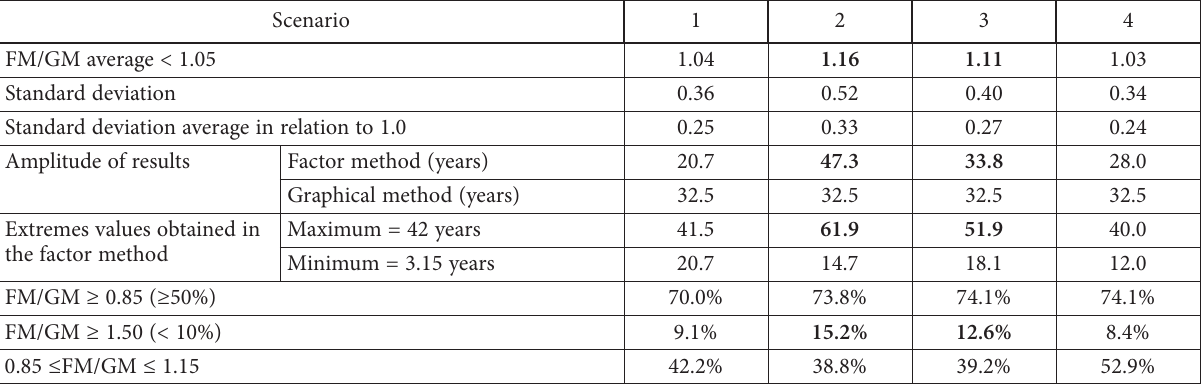
Table 3. Statistical indicators of the results obtained for each scenario